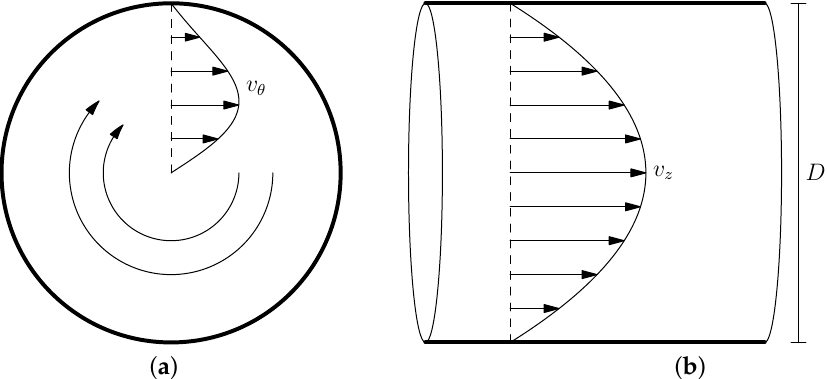
Figure 1. Typical velocity profiles in a swirling flow inside a circular pipe with D = 2 R , represented by ( a ) tangential velocity (left) and ( b ) axial velocity